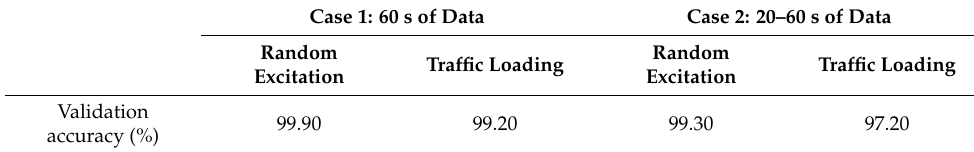
Table 5. Classification results of training cases.